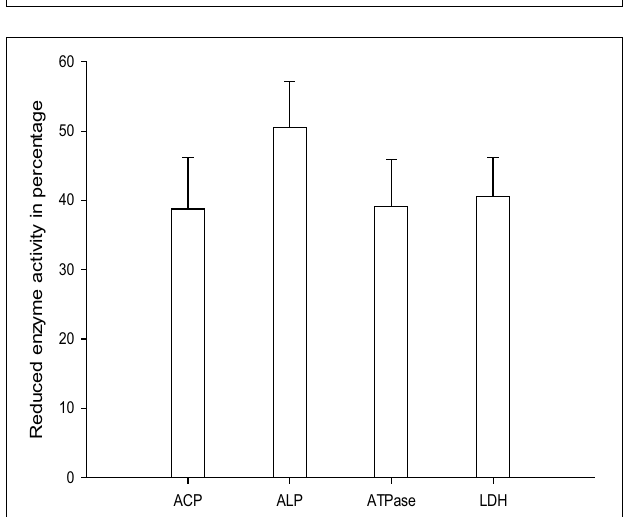
FIGURE 5 | Activity of ATPase and LDH against the 1 ppm treatment of azadirachtin on C. medinalis .